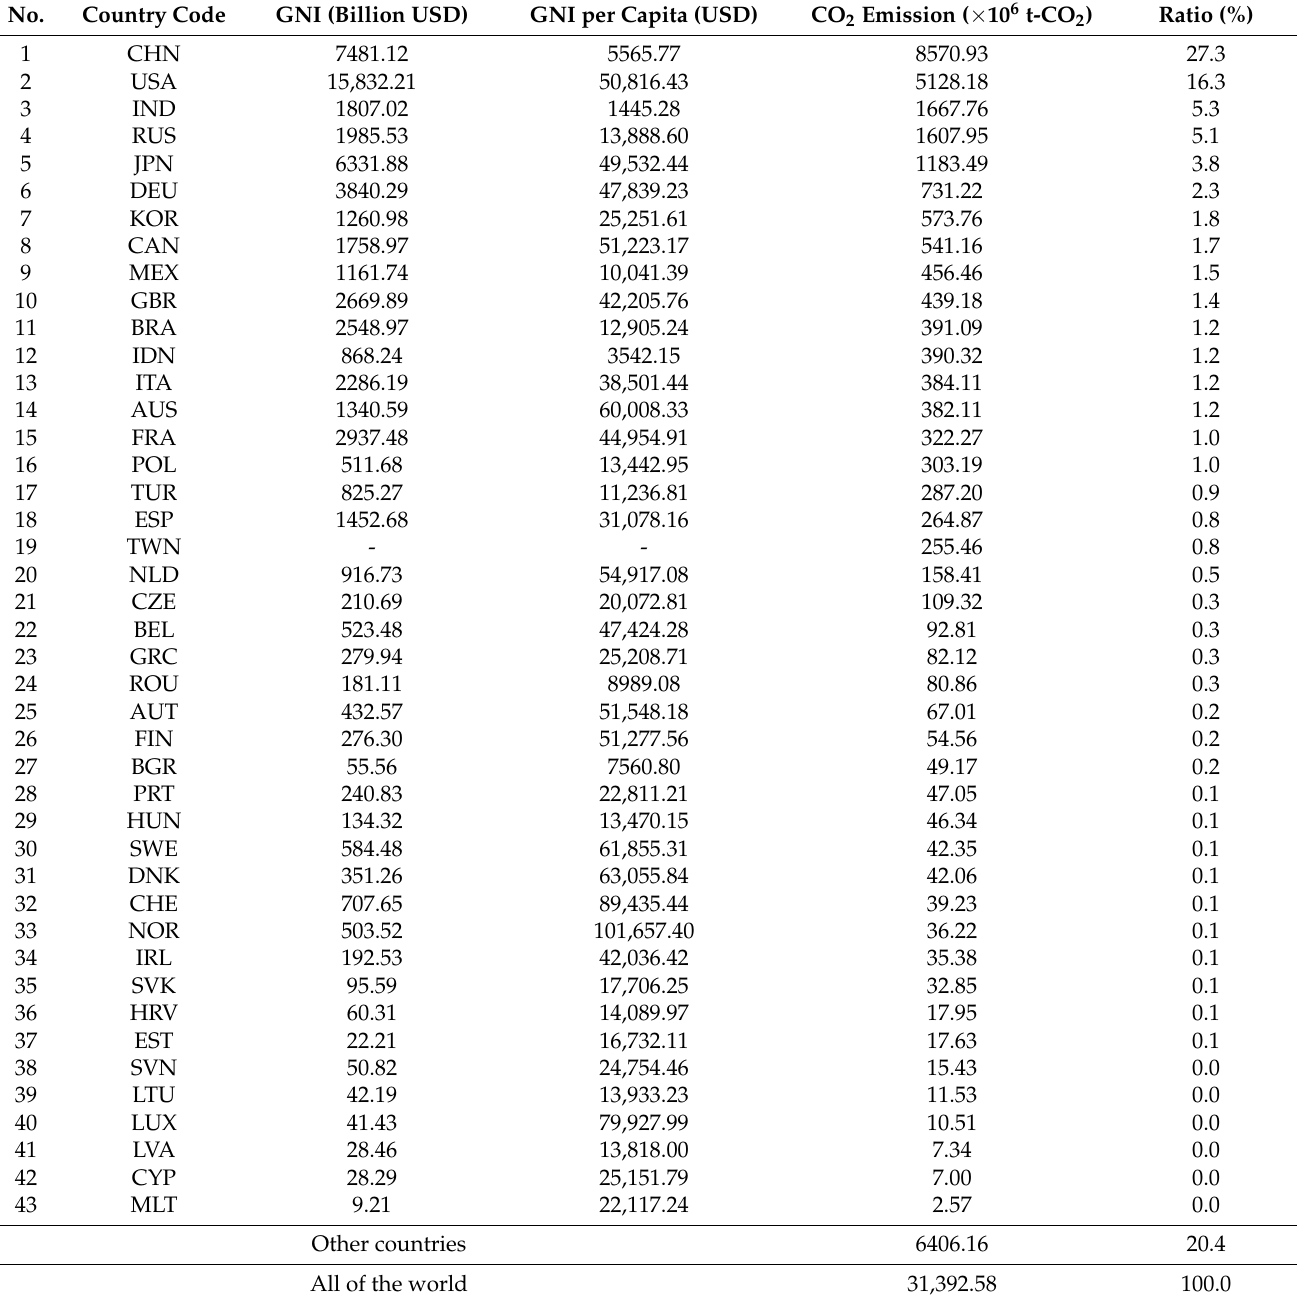
Table 2. List of countries, along with their gross national income (GNI) [12,13] and CO 2 emissions [14]